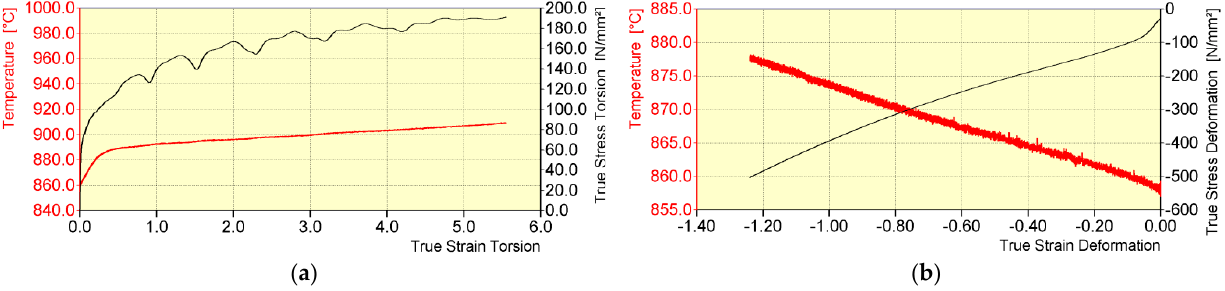
Figure 11. General course of temperature (nominal and obtained) and yield stress during physical modelling of rolling a 20MnB4 steel wire rod with a diameter of 5.5 mm (test variant V3): ( a ) in an NTM block (torsion) and ( b ) in the RSM block (tension).